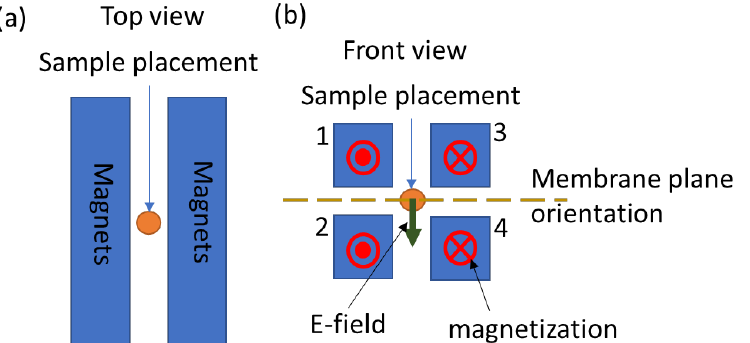
Figure 1. Experimental geometry. ( a ) Top view of the EPM array with a centrally positioned sample (orange circle). ( b ) Front view of the EPM array, showing four EPM assemblies with magnetizations directed along the length of each EPM assembly. The direction of the electric field is shown by an arrow, and a dotted line depicts the orientation of the transwell membrane (on which the Caco-2 cells are grown) for in vitro experiments. The EPM magnet assemblies are numbered 1 through 4.